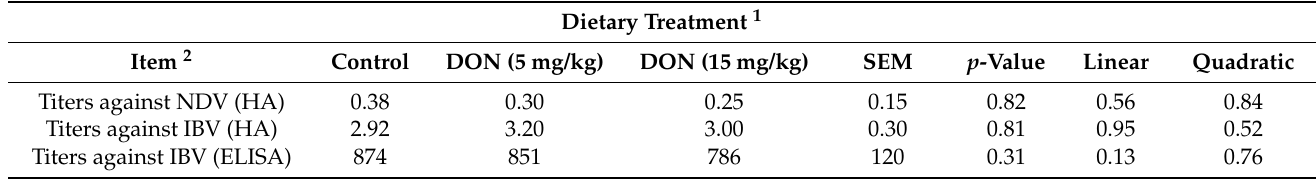
Table 6. Effects of DON-contaminated feed (5 and 15 mg/kg) on antibody titers against NDV and IBV in broiler chickens. Dietary Treatment